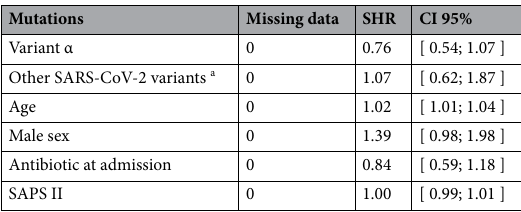
Table 3. Multivariable Fine and Gray model analysis on risk of ventilator-acquired pneumonia. SHR sub- hazard ratio, CI 95% 95% confidence interval; a pre-existing variant or other